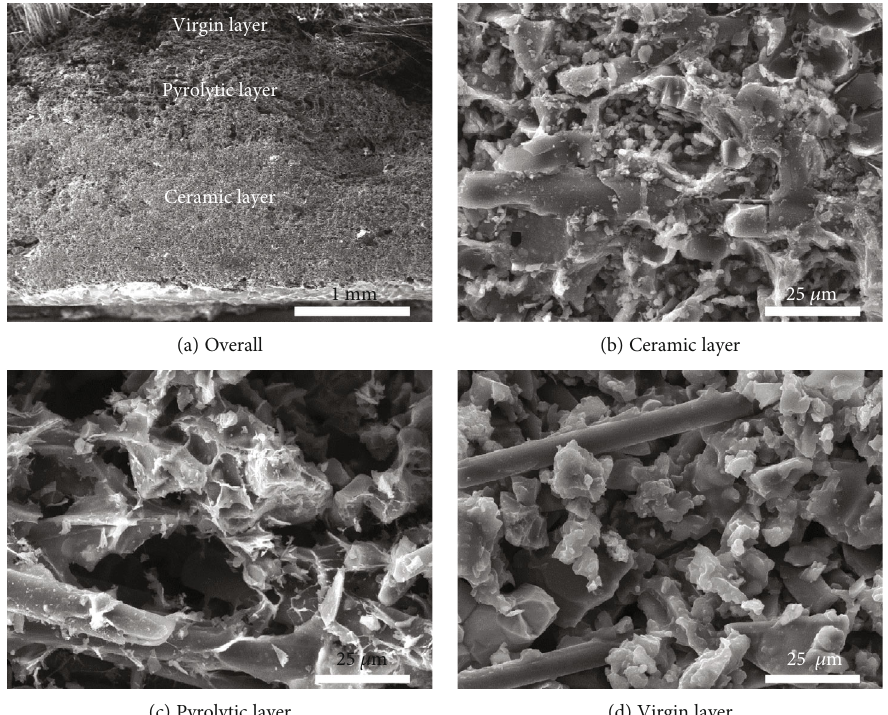
Figure 7: Section morphology of the specimen E3 at di ff erent